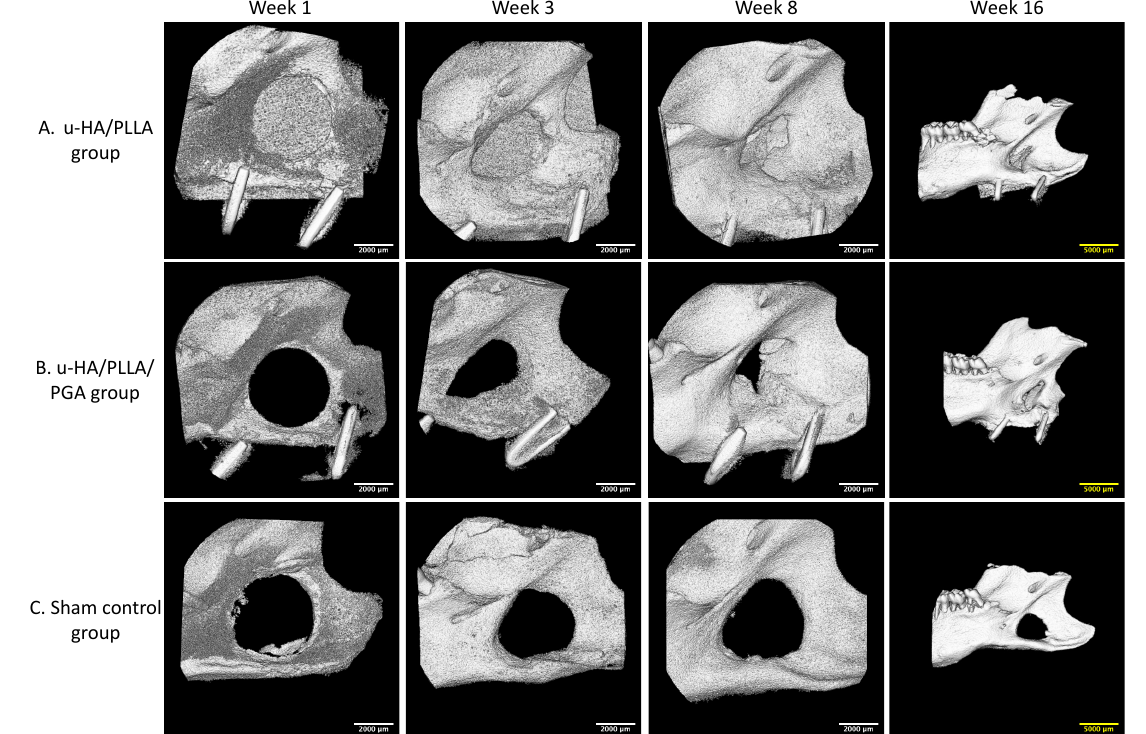
Figure 7. 3D micro-CT images. ( A ) 3D views of the u-HA/PLLA group. ( B ) 3D views of the u-HA/PLLA/PGA group. Newly formed bone increased over time. ( C ) 3D views of the sham control group. New bone formation could not be identified. To present a broad view, images at week 16 are lower magnification than images at other weeks. Scale bars: 2000 μ m (white), 5000 μ m (yellow).